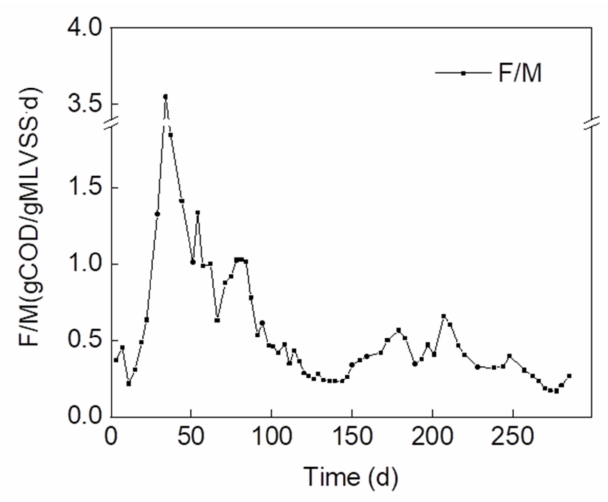
Figure 6. F/M ratios in the reactor during the long-term operation period.